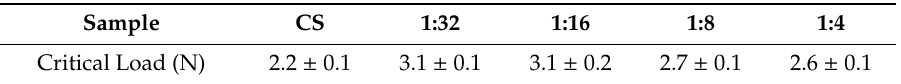
Table 3. Critical load values obtained by scratch test with respect to the standard deviation of CS and Ga (III)-CS coatings.